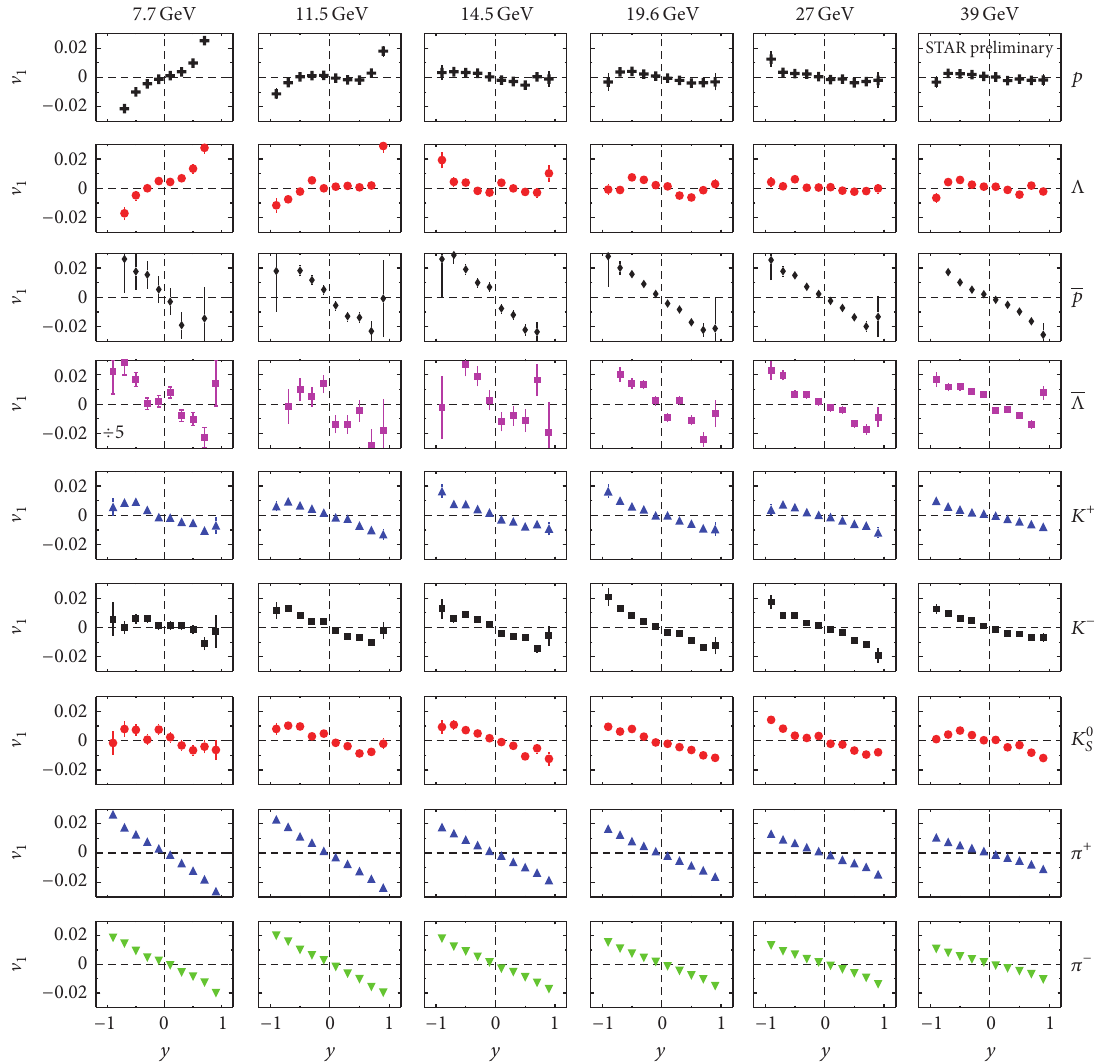
Figure 10: Directed flow as a function of rapidity for 𝑝 , Λ , 𝑝 , Λ , 𝐾 ± , 𝐾 0 𝑆 , and 𝜋 ± in 10–40% centrality Au+Au collisions, at √𝑠 NN values of 7.7, 11.5, 14.5, 19.6, 27, and 39 GeV [47, 90]. The magnitude of V 1 for Λ at 7.7GeV is divided by 5 to fit on the same vertical scale as all the other